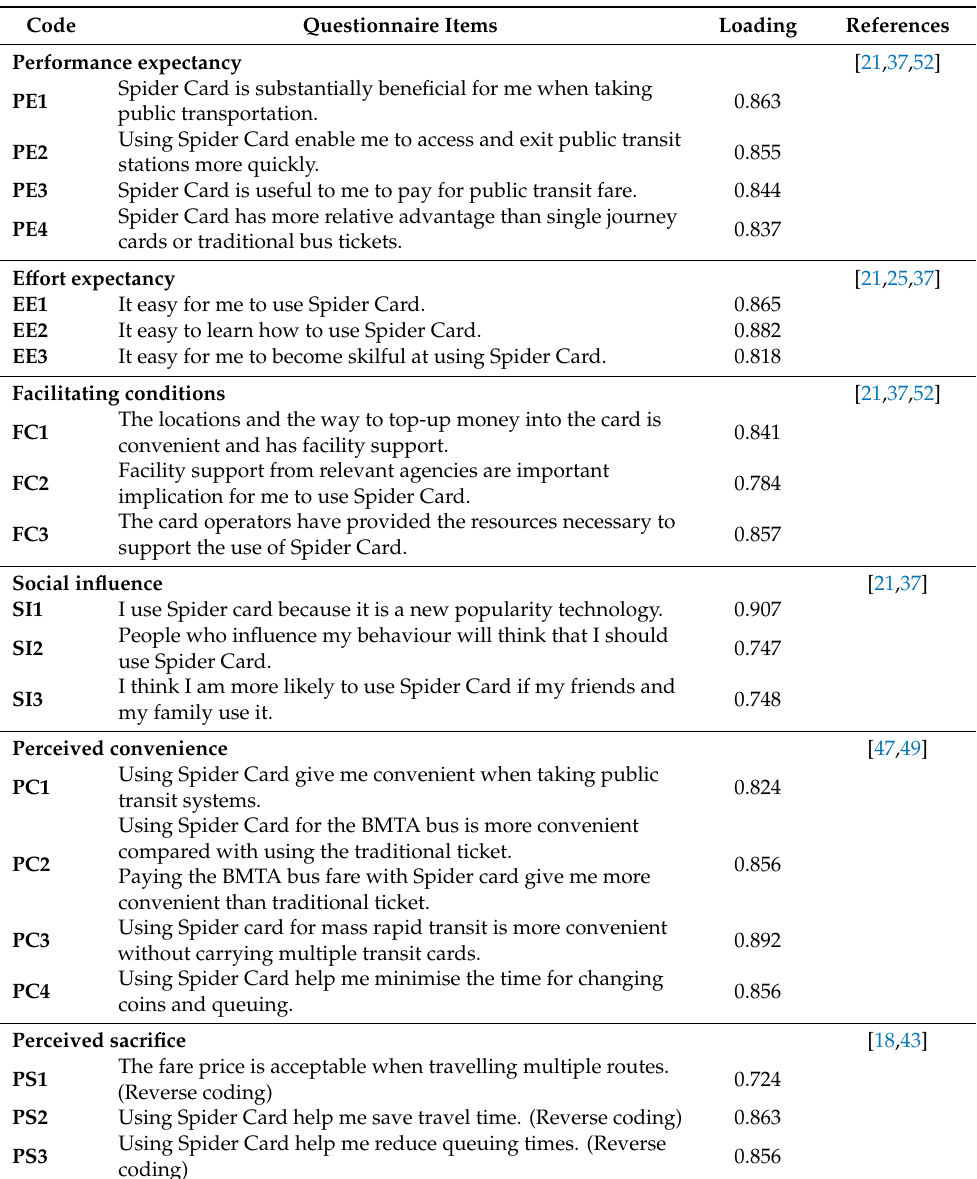
Table A1. Questionnaire